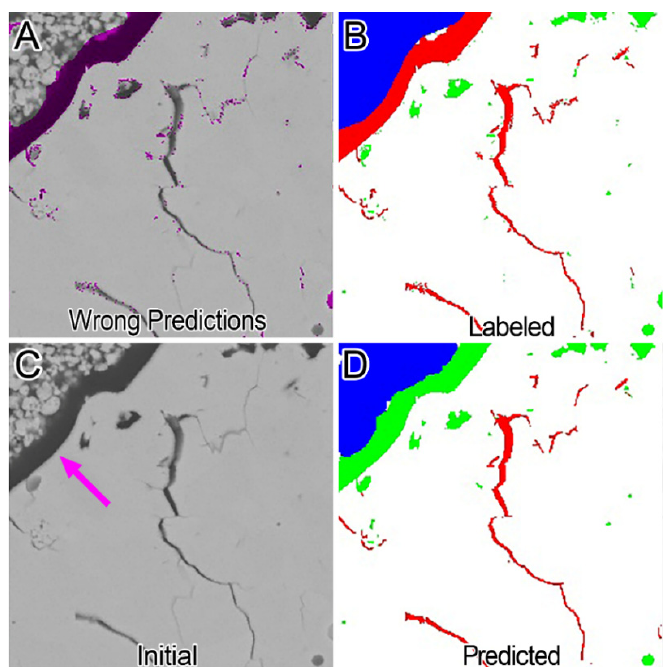
Figure 16. Test image for which cracks were wrongly predicted as equiaxed pores. ( A ) The grayscale image with wrong predictions are marked by purple, ( B ) the labeled image, ( C ) the initial grayscale image The arrow indicates a crack next to an unmelted region that was wrongly predicted as an equiaxed pore, and ( D ) the predicted image.